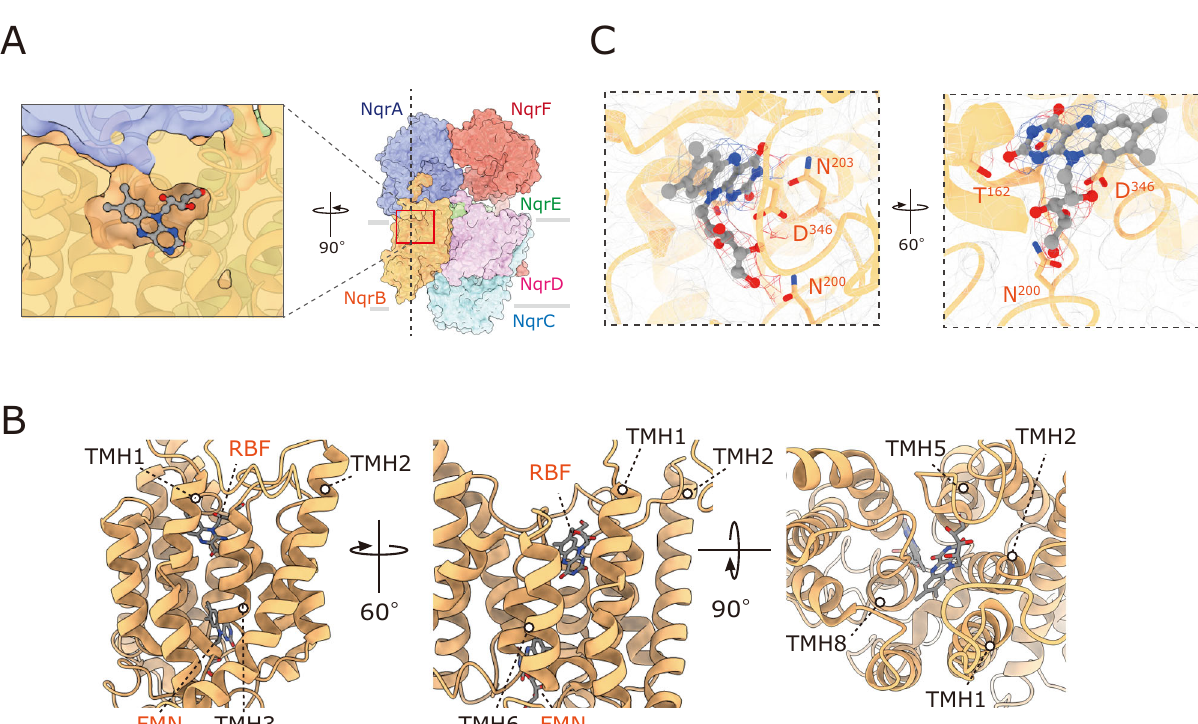
Fig. 4 Ribo fl avin is located in NqrB. A , B The positions of ribo fl avin (RBF) and FMN in NqrB are indicated. Ribo fl avin ( sticks model) is surrounded by central TMHs 1, 3, 5, and 8 ( cartoon model). C Close-up view of the binding site of ribo fl avin ( ball-and-sticks model). The density map is shown as a mesh representation. The residues suggested to be involved in hydrogen bonds with ribo fl avin are indicated.